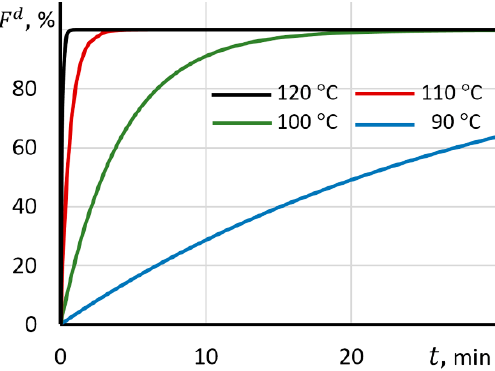
Figure 3. The percent change of dead bacterial spores versus time at different temperatures.